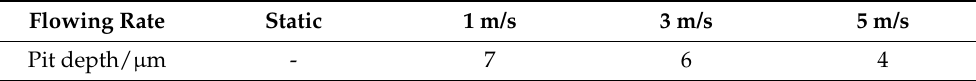
Table 2. Depth of pits of HAZ corroded in different flowing rates of seawater for 30 days. Flowing Rate